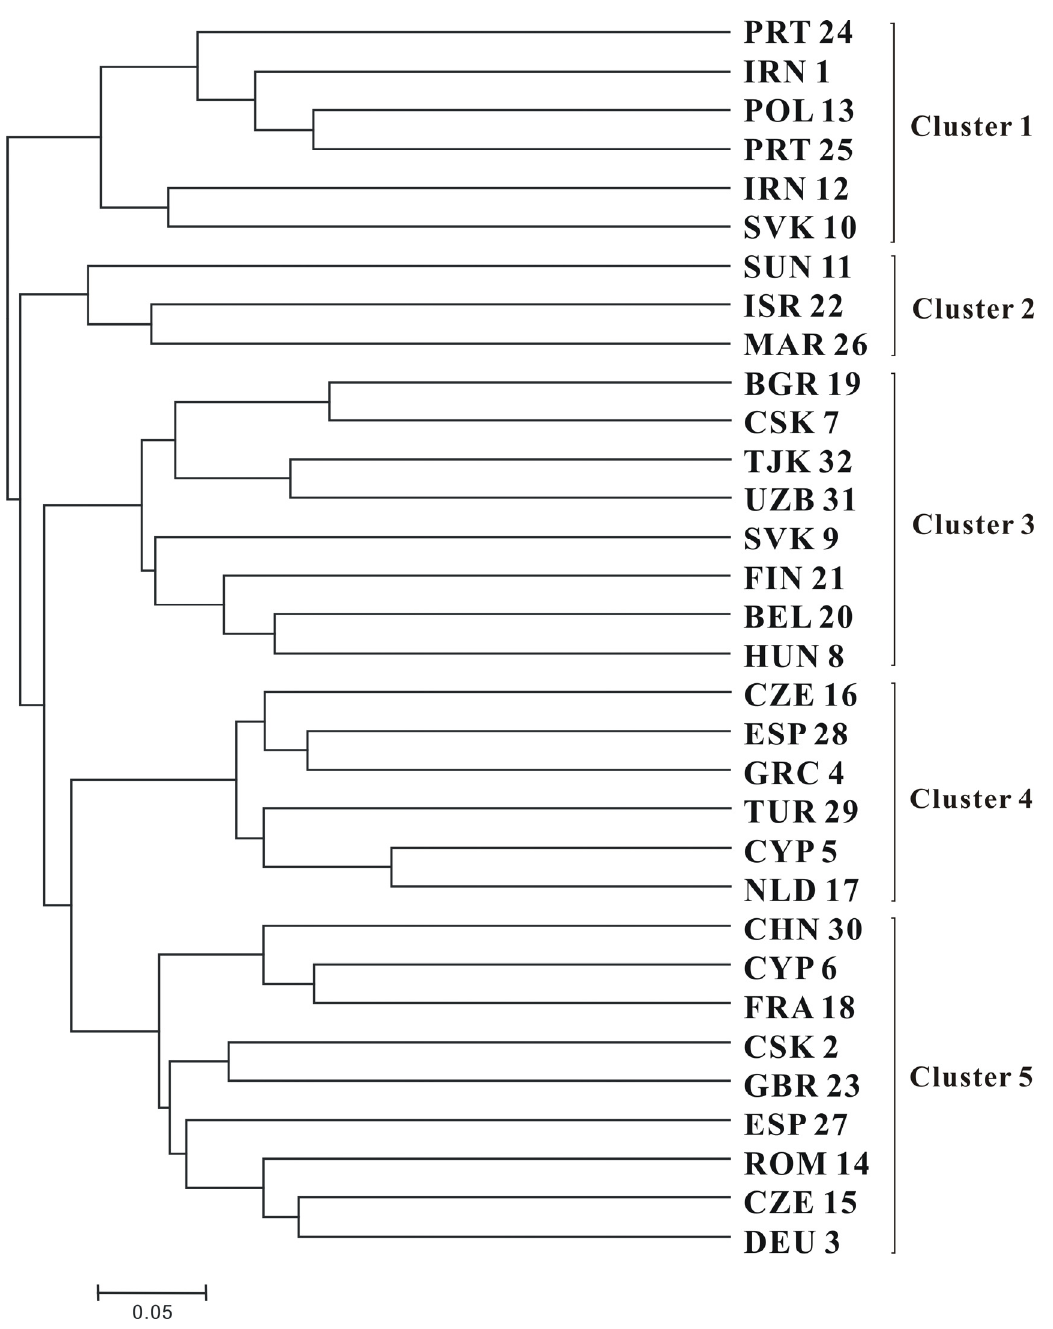
Figure 1. Dendrogram generated using UPGMA cluster analysis based on genetic diversity of 32 common vetch ( Vicia sativa subsp. sativa )